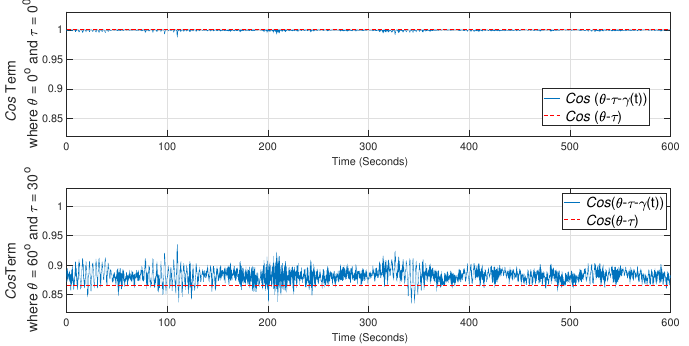
Figure 13. Cos term evaluation for rated wind speed (10 m/s) for set θ = 0 ◦ , τ = 0 ◦ ( above ) and for set θ = 60 ◦ , τ = 30 ◦ ( below ).